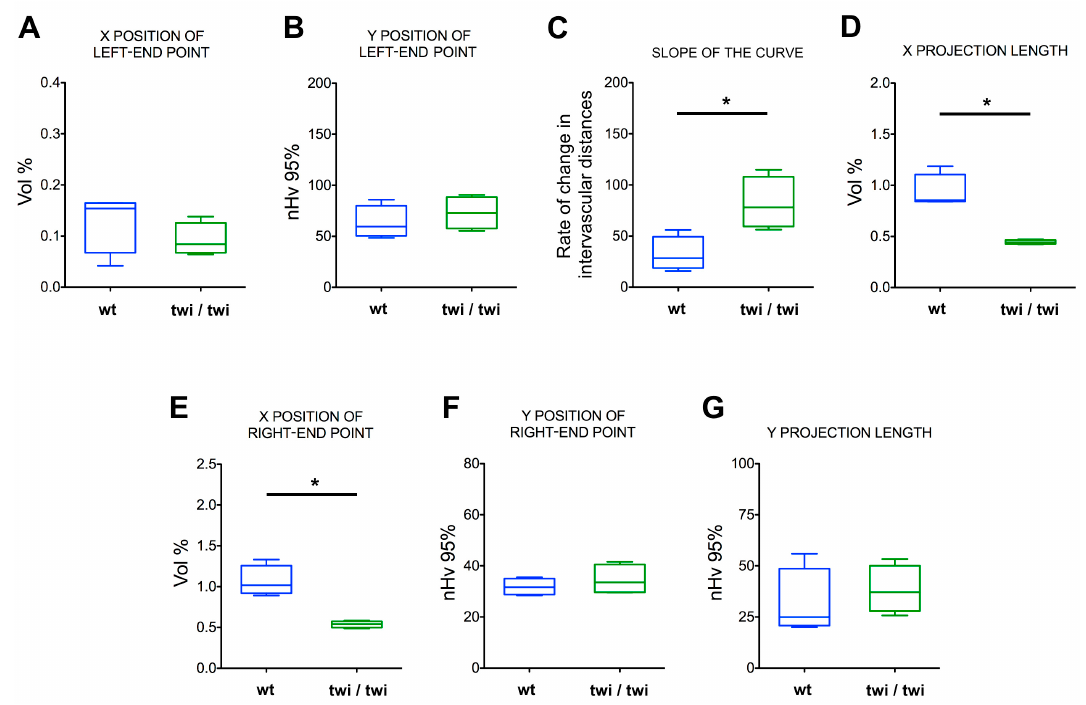
Figure 5. Vascular parameters of the brain cortex microvascular angioarchitectures in wt and twitcher mice. Box and whiskers plots of curve-derived, interdependent vascular parameters from prefrontal cortex angioarchitectures in wt and twitcher mice. ( A ) X position of the left-end point, representing the percent volume (Vol%) occupied by signal from the largest vessels. ( B ) Y position of the left-end point, representing the spatial dispersion of the largest vessels (higher values reflect a higher clusterization). ( C ) Slope of the curve, representing change in intervascular distances according to vessel caliber reduction. ( D ) Length of projection on the X-axis, representing the Vol% occupied by vessels smaller than the initial class. ( E ) X position of the right-end point, representing the Vol% of the totally reconstructed set of analyzed vessels (i.e., the Vol% of total vasculature analyzed). ( F ) Y position of the right-end point, representing the distribution of the total vasculature analyzed. ( G ) Length of projection on the Y-axis, representing the contribution of smaller vessels to the distribution of the total vasculature. Boxes extend from the 25th to the 75th percentiles; the lines indicate the median values, and the whiskers indicate the range of values. * p < 0.05.